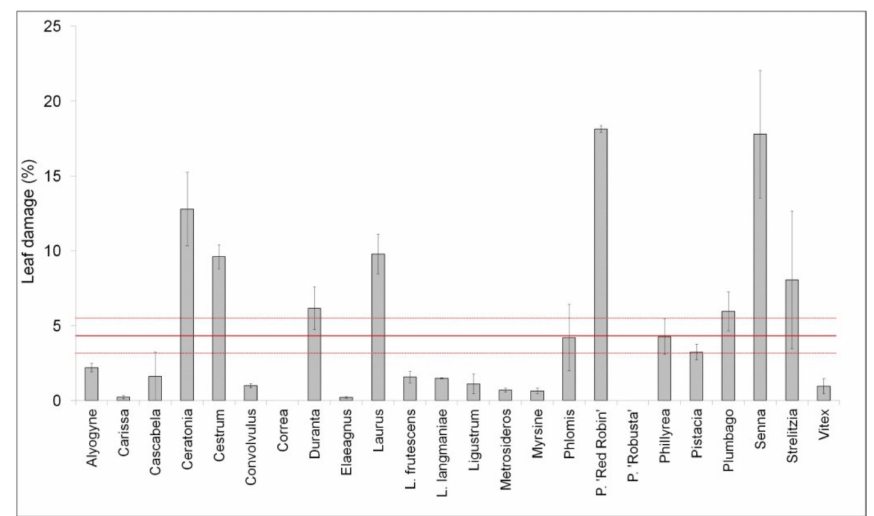
Figure 2. Leaf damage percentage in twenty-four ornamental species exposed to salt spray for 60 days. Values are means ± standard errors ( n = 6). The horizontal red lines show the average value ± standard errors.